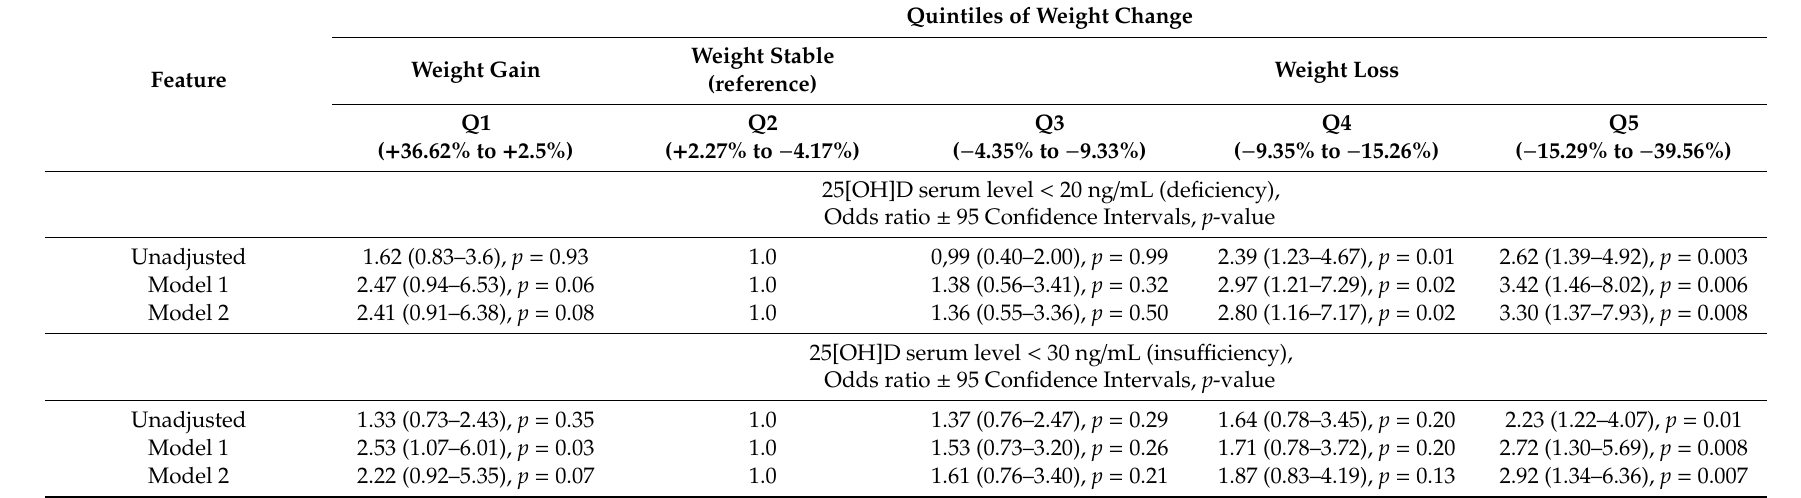
Table 2. Quintiles of WC in HF and the risk of 25[OH]D deficiency / insu ffi